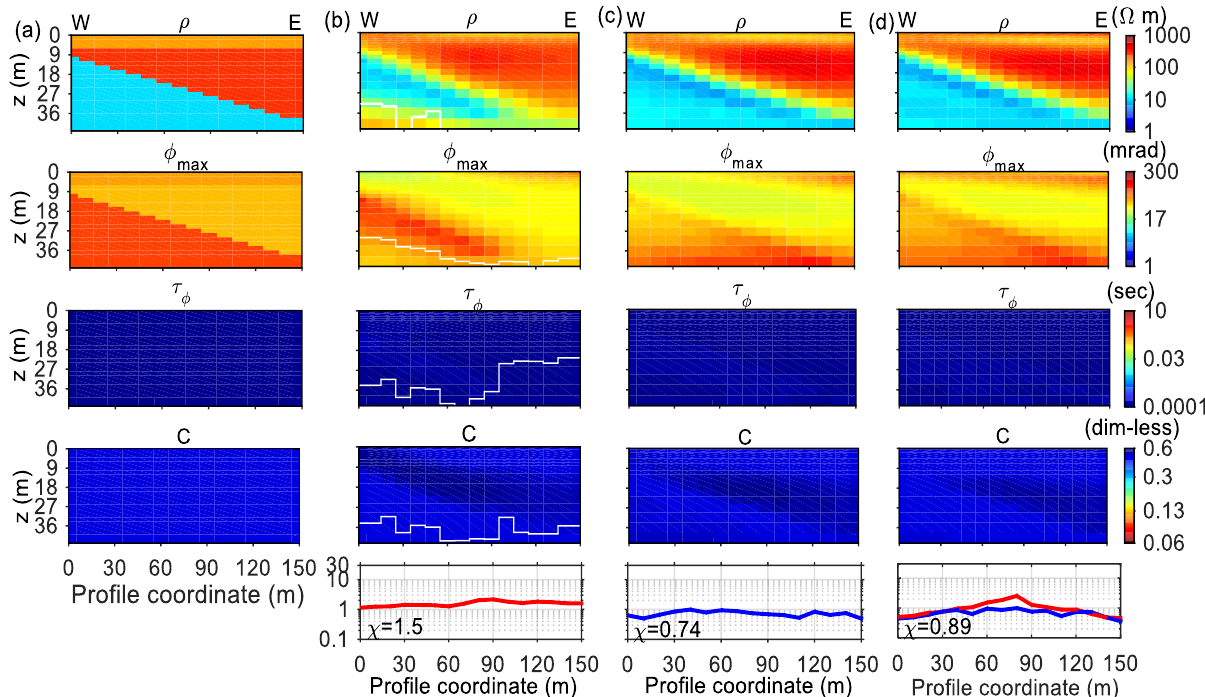
Figure 12. Comparison between the true model ( a ) and estimated MPA parameters of the moderate chargeable medium: by x -data only ( b ); z -data only ( c ); and x and z data ( d ). The meanings of the curves and the area are the same as in Figure 7.